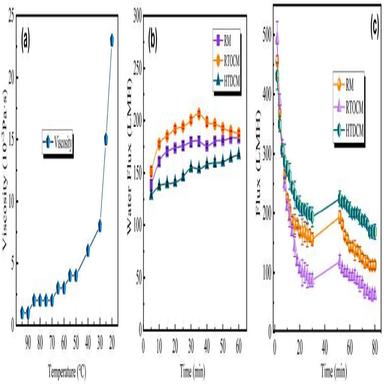
(a) Variations in the viscosity of sugar juice as a function of the filtration temperature. (b) Pure water fluxes of RM, RTOCM and HTDCM (TMP, 1 bar; crossflow velocity, 4 m/s). (c) Variations in the permeate fluxes of RM, RTOCM and HTDCM as functions of time (TMP, 4 bar; cross-flow velocity, 4 m/s).